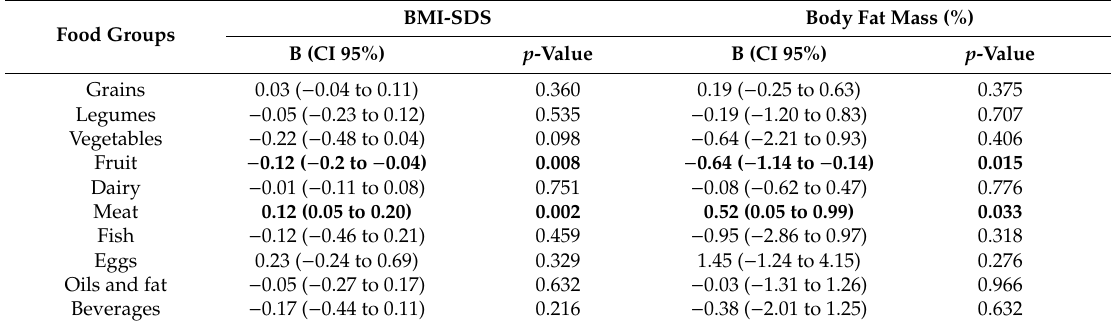
Table 5. Associations between food group intake and BMI-SDS or